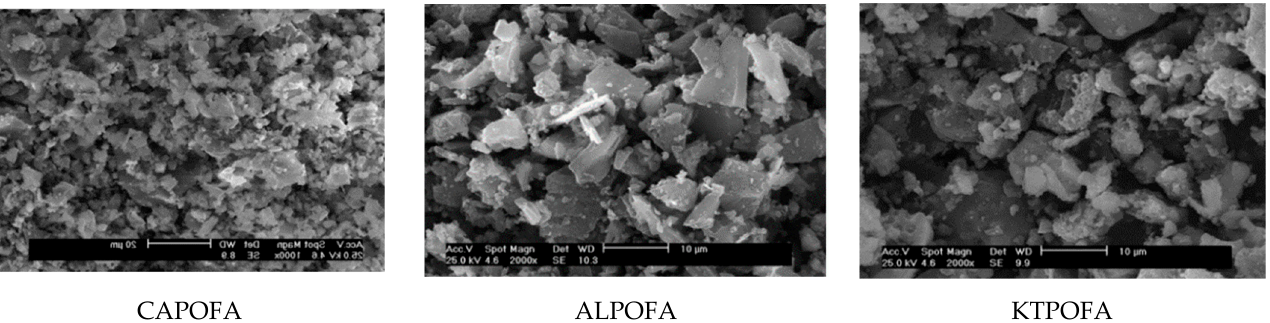
Figure 3. Scanning-electron-microscopy (SEM) [30]. Reprinted with permission from Elsevier [30].